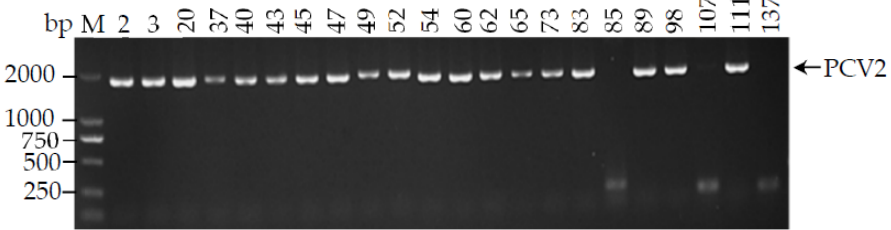
Figure 2. Partial PCV2 positive samples were used to amplify the complete genome of PCV2. The PCR products with about 2000 bp were separately by 1% agarose gel electrophoresis. M: DL2000 marker.